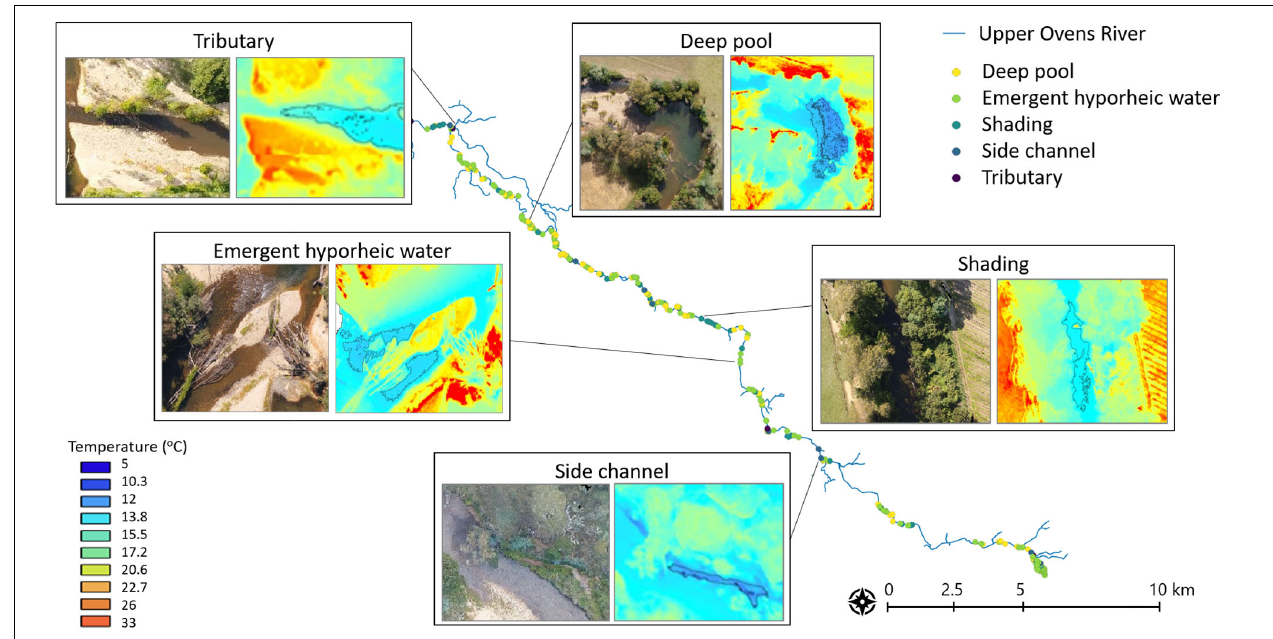
FIGURE 5 | Illustrations of examples for each of the four CWPs types identified, and their locations, along the Upper Ovens River.